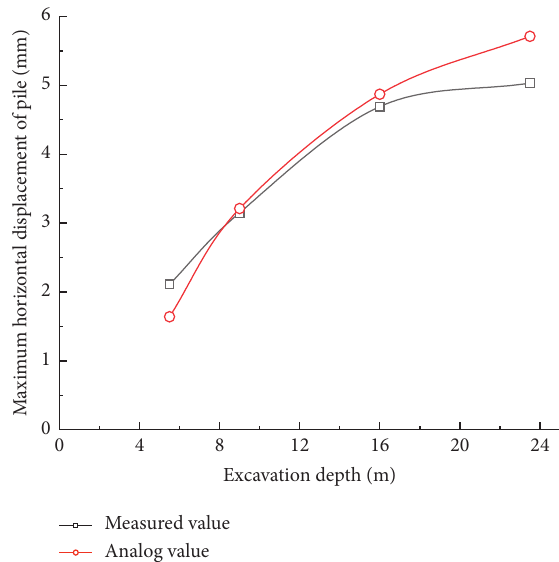
Figure 5: The relationship between maximum horizontal displacement of the pile and excavation depth.